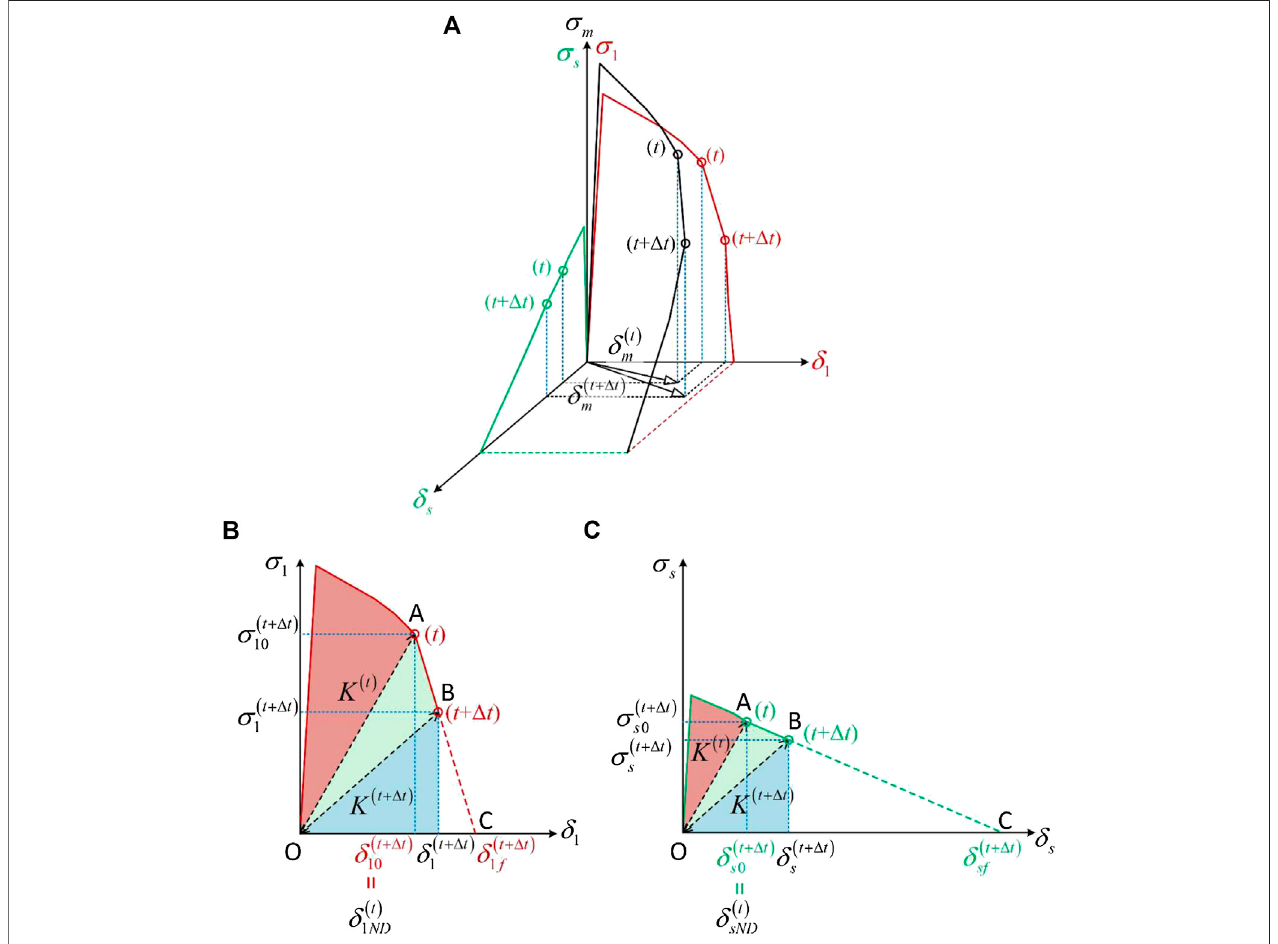
FIGURE 3 | Mixed-mode constitutive curve: (A) constitutive curves in the mixed-mode space; (B) decomposition of mixed-mode constitutive curve on the mode I plane; (C) decomposition of the mixed-mode constitutive curve on the shear mode plane.